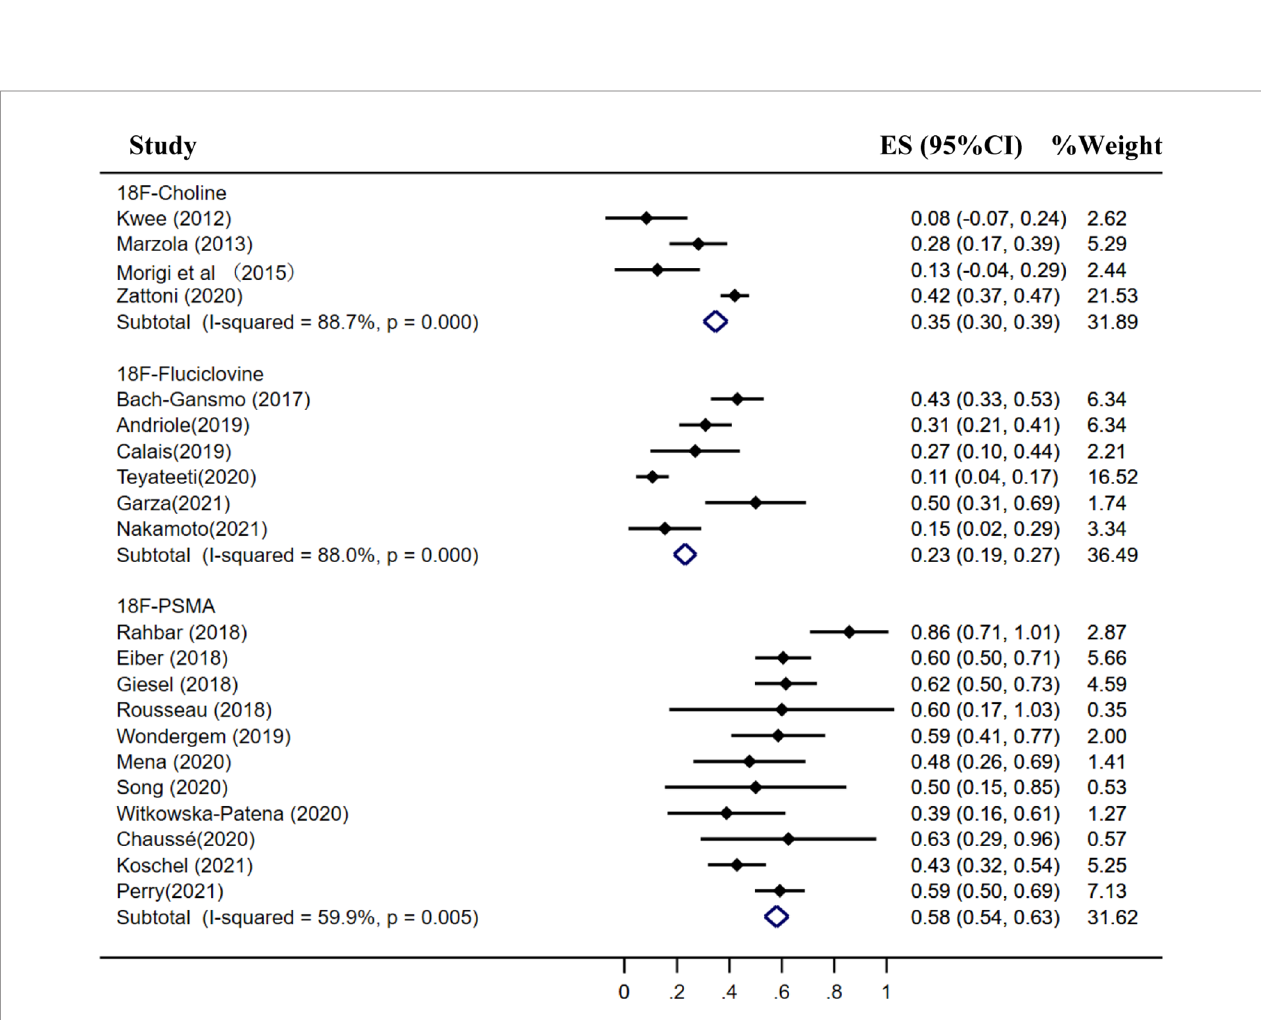
FIGURE 7 | Forest plot of the proportion of 18 F-labeled choline, fl uciclovine and PSMA positivity of prostate cancer patients with BCR for PSA less than 0.5